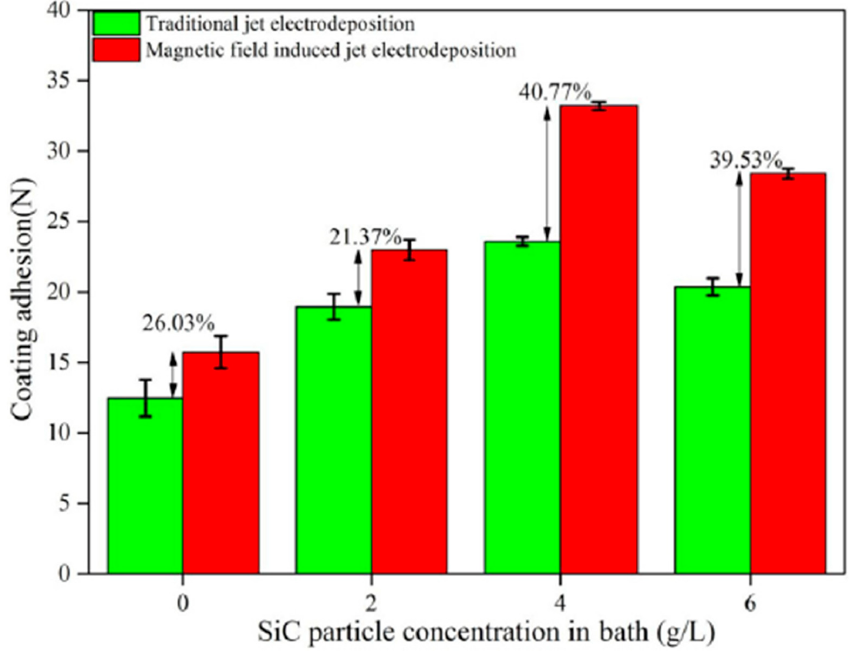
Figure 12. Adhesion of the composite coatings [120]. Reprinted from Journal of Alloys and Compounds, 791, Wei Jiang, Lida Shen, Mingyang Xu, Zhanwen Wang, Zongjun Tian, Mechanical